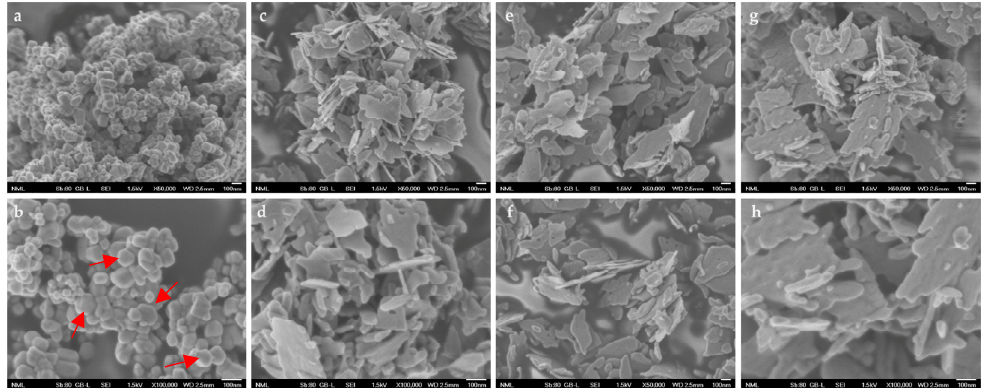
Figure 8. Representative FESEM images of produced ZnO type particles prepared from: ( a ) zinc acetate (×50,000), ( b ) zinc acetate (×100,000), ( c ) zinc chloride (×50,000), ( d ) zinc chloride (×100,000), ( e ) zinc nitrate (×50,000), ( f ) zinc nitrate (×100,000), ( g ) zinc sulfate (×50,000), and ( h ) zinc sulfate (×100,000). Red arrows are used in order to point out some of the hexagonal-shaped particles in the case of ZnAc.